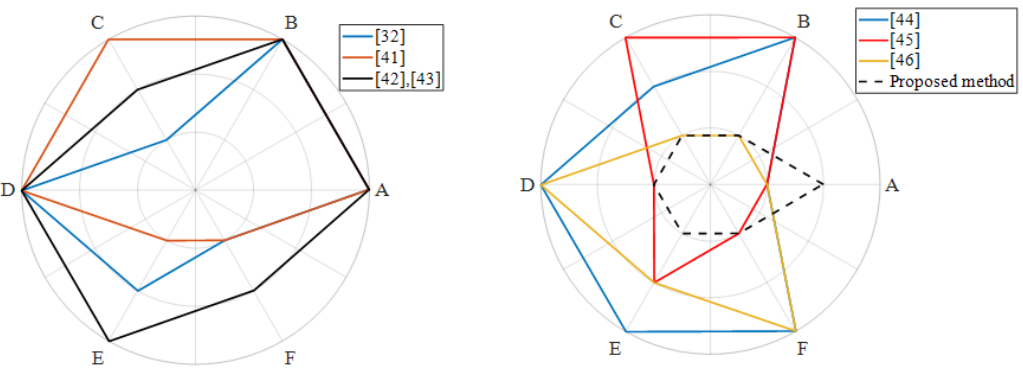
Figure 16. Comparative evaluation of existed and proposed scheme, (A) cost, (B) size, (C) operation time, (D) complexity, (E) coordination problem, (F) power losses.